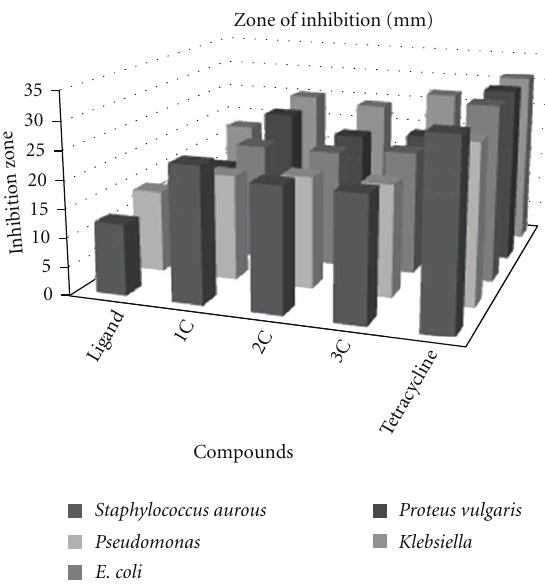
Figure 2: Antibacterial activity of the ligand and its metal com-